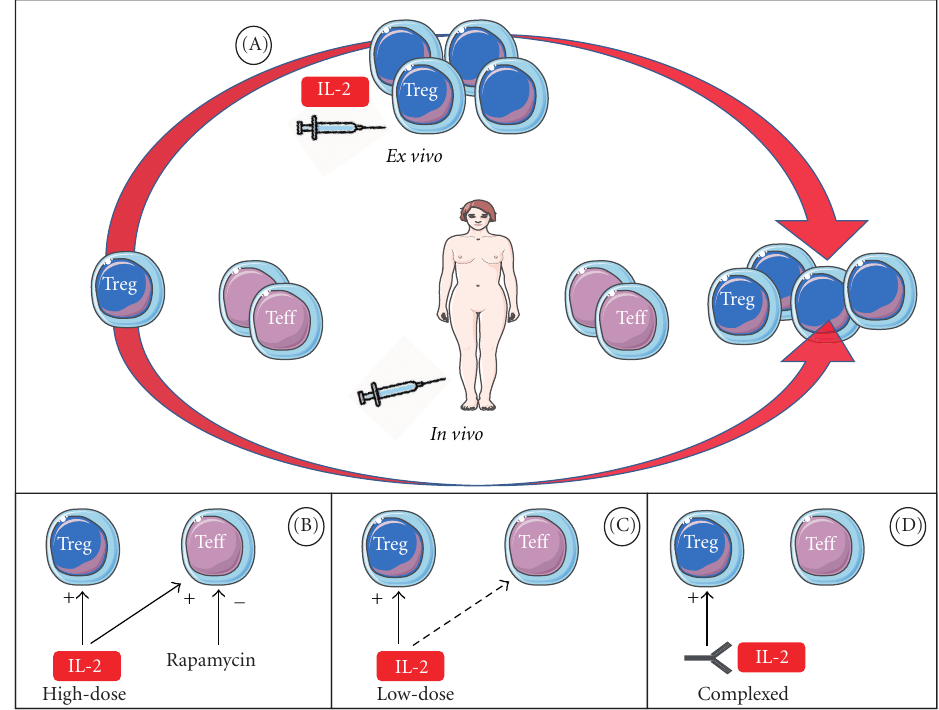
Figure 2: Di ff erent IL-2 based approaches to promote the expansion of regulatory T cells (Treg). A first approach consists of using IL-2, together with other stimuli, to expand ex vivo the Treg cells collected from a patient’s tissue culture before transferring these cells to the patient (A). In vivo , IL-2 can be administered subcutaneously at high doses but can be associated with rapamycin to prevent activation of e ff ector T cells (Te ff ) (B) or given at a low dose for the same reason (C). IL-2-specific monoclonal antibodies can be used to target IL-2 selectively to Treg cells